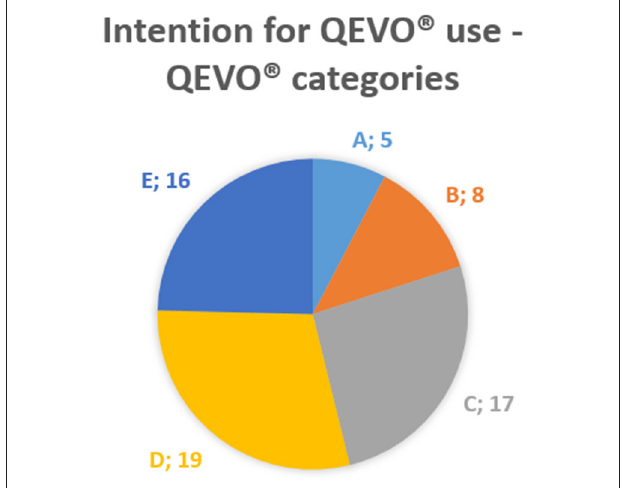
FIGURE 6 | QEVO® categories. A, target localization; B, tailoring the approach; C, looking beyond; D, resection control; E, inspection of remote